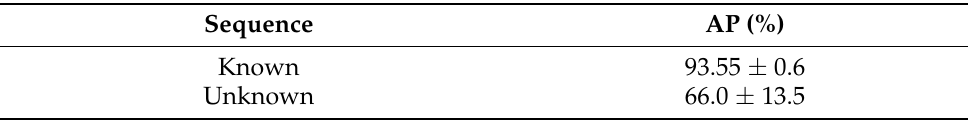
Table 3. Results (AP) of Alexis team approach when testing on known and unknown sequences sampled from the 2020 Drone vs. Birds Challenge. The mean and standard deviation for 5 different data splits (1 run per data split) was reported.